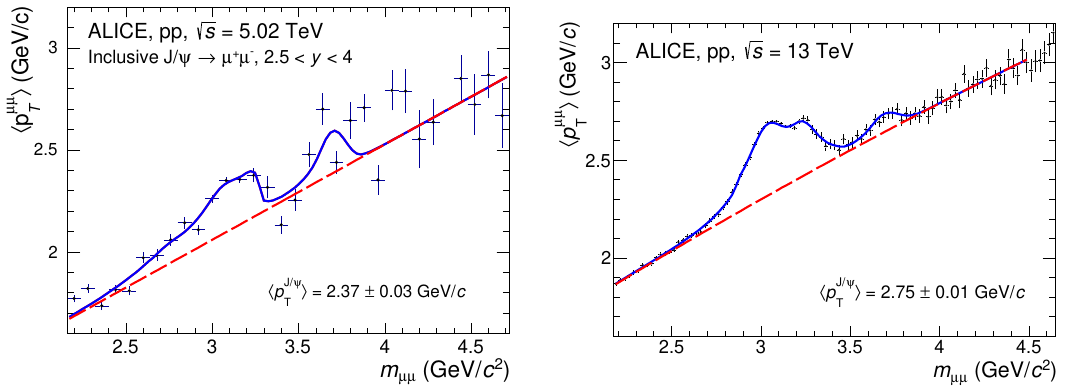
Figure 3 . Example of h p J/ψ i extraction in integrated multiplicity using the piece-wise function for T √ pp collisions at s = 5 . 02 and 13